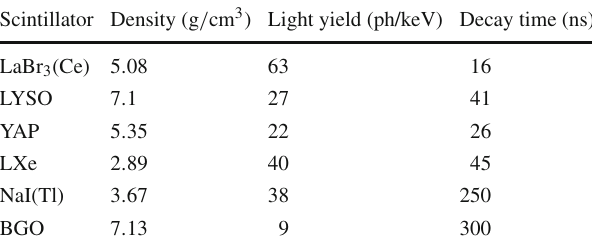
Table1 Propertiesofstate-of-the-artscintillatorsrelevantfortheappli- cation on μ + → e + γ